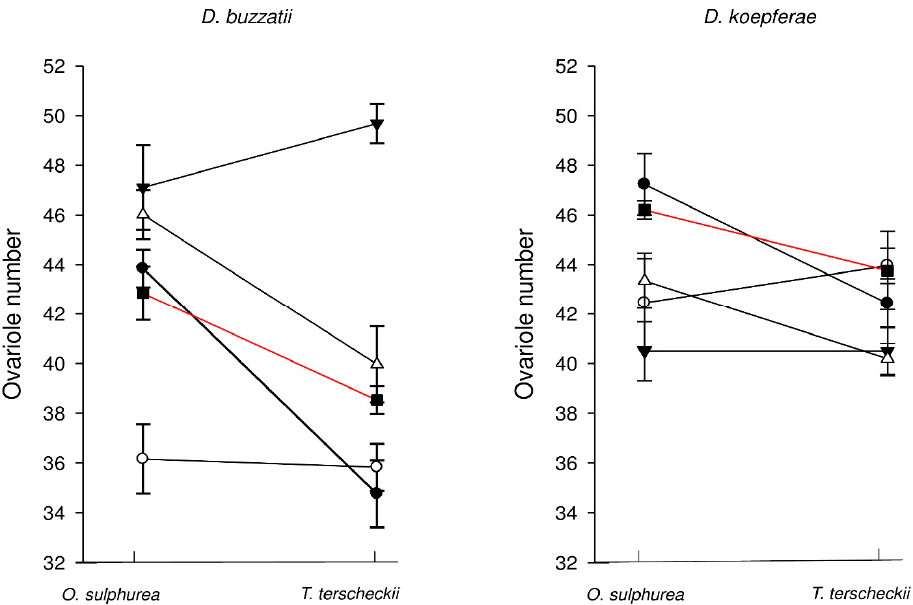
Figure 3. Norms of reaction of all genotypes reared in alternative cacti. Black reaction norms correspond to genotypes derived from the locality of Valle Fértil while red reaction norms correspond to genotypes derived from populations of different geographic origins.